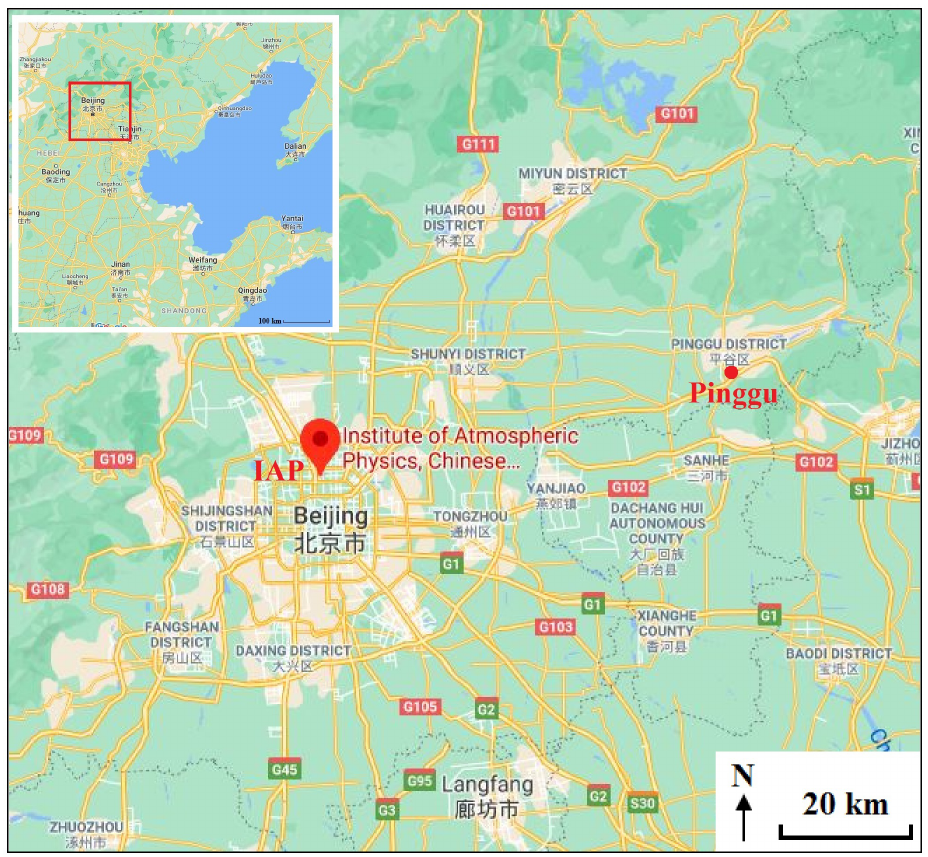
Figure 1. Locations of the sampling sites in Beijing (IAP – urban site: Institute of Atmospheric Physics of the Chinese Academy of Sciences; Pinggu – rural site) (source: © Google